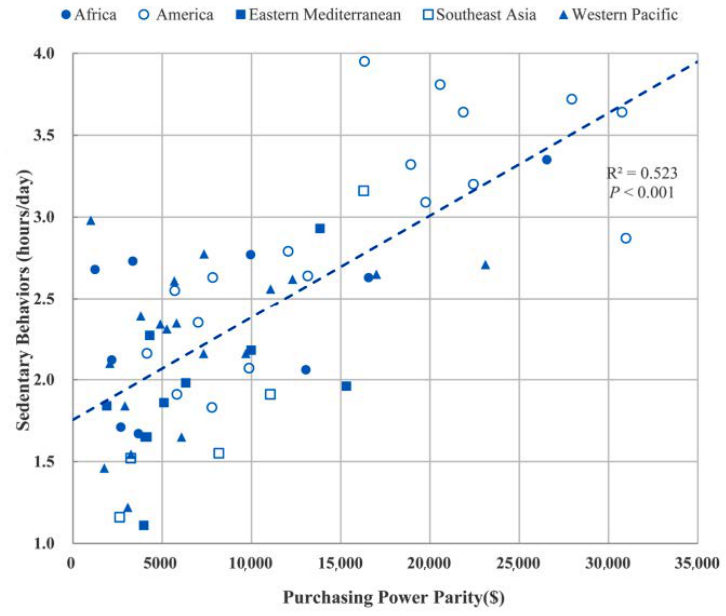
Figure 2. Mean daily duration of sedentary behavior (except for sitting time at school or for homework) by purchasing power parity per capita in 68 LMICs and 5 WHO regions. 3.3. Country PPP per Capita and Its Association with Combined Insufficient Physical Activity and/or High Sedentary Behavior The overall prevalence of having both sufficient physical activity ( ≥ 1 h per day) and low sedentary time ( ≤ 2 h per day) was only 9.1%, and was lowest in the Philippines (3.4%) and highest in Bangladesh (35.0%) (Table S2).The prevalence of having sufficient physical activity and low sedentary behavior was higher in boys than in girls in Africa (12.1% vs. 7.3%), America (11.2% vs. 6.1%), and East Mediterranean(10.5% vs. 6.6%) regions, as well as in the last three upper PPP/capita quintiles (Q3, 12.6% vs. 8.1%; Q4, 11.5% vs. 5.3%; Q5, 10.0% vs. 4.9%), but did not differ significantly across WHO regions(Table 5). The prevalence of having insufficient physical activity and high sedentary behavior (>2 h per day) did not differ according to sex, WHO region, or PPP/capita categories (except for Q4, boys vs. girls: 37.7% vs. 48.0%), while it was the highest in America (boys: 32.7%, girls: 41.1%) and the lowest in Southeast Asia (boys:18.7%, girls:19.3%) (Table 5). The prevalence of having sufficient physical activity and low sedentary behavior and the prevalence of having insufficient physical activity (<1 h/day) and low sedentary behavior ( ≤ 2 h/day) decreased along increasing PPP/capita quintiles among both sexes, while there were upward trends with increasing PPP/capita quintiles among both sexes in the other two groups (Table 5). Compared to countries with the lowest quintile of PPP, young adolescents in countries with higher quintiles of PPP were less likely to have both sufficient physical activity and low sedentary time (Q2: OR = 0.30, 95% CI = 0.28–0.36; Q3: 0.42, 0.36–0.50; Q4: 0.34, 0.29–0.41; Q5: 0.40, 0.34–0.47) after adjustment for sex, age, and survey year, whereas odds ratios for not having both sufficient